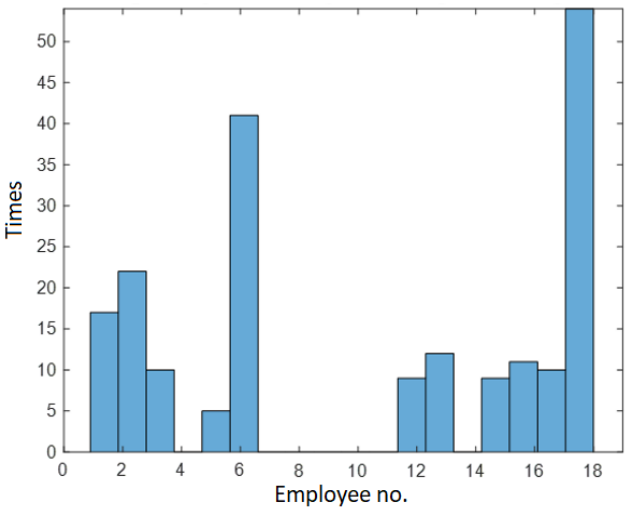
Figure 15. Number of changes after 200 program activations.